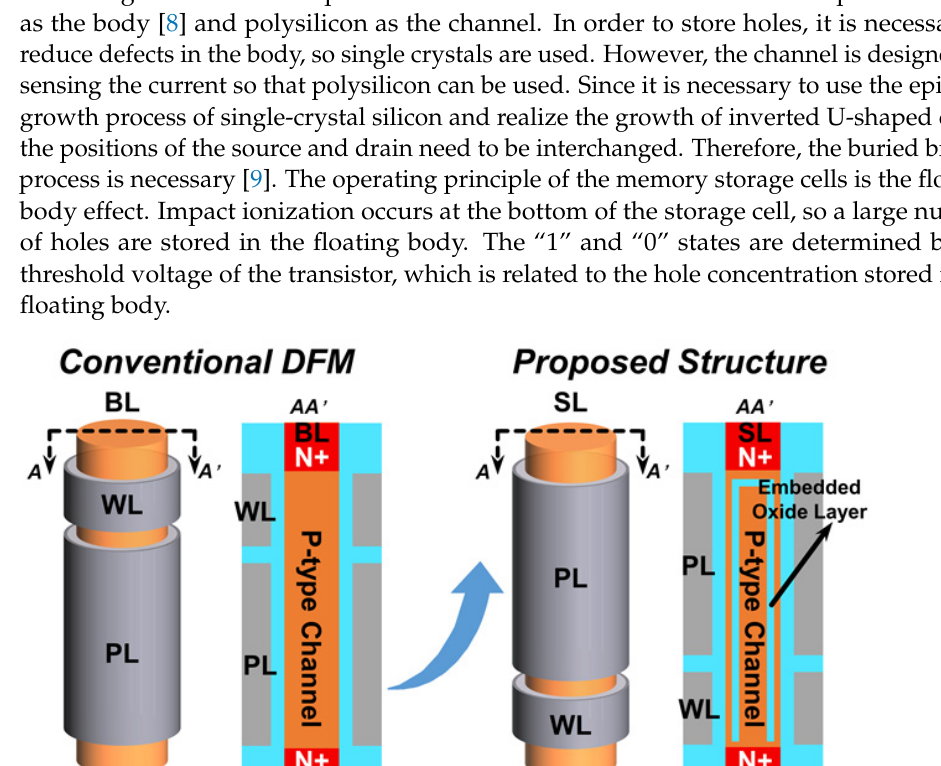
Figure 2. ( a – f ) The process flow of the1T DRAM with embedded oxide layer.